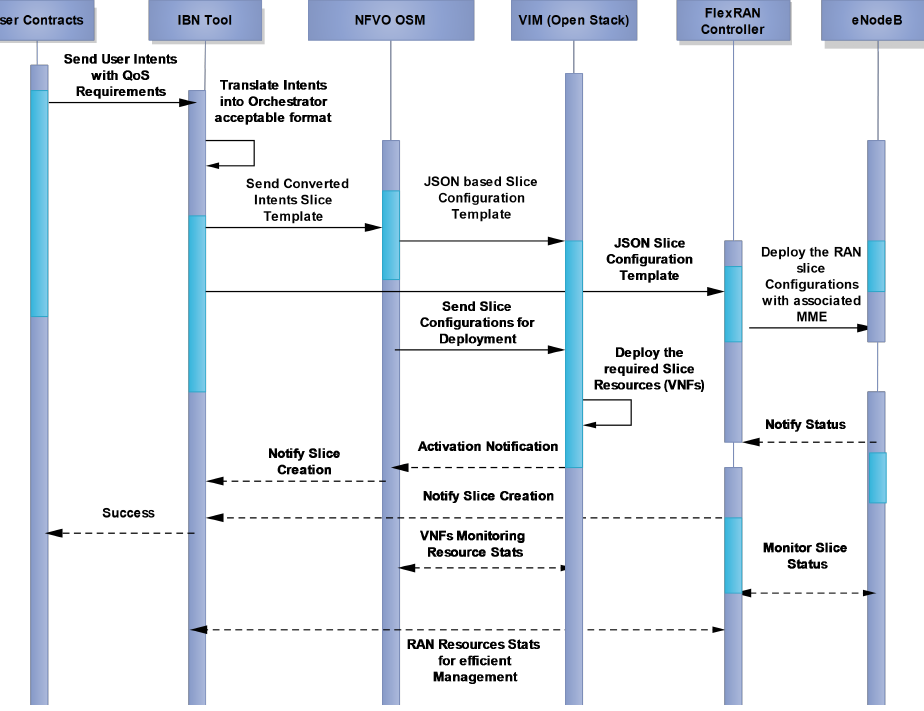
Figure 9. Network slice instantiation